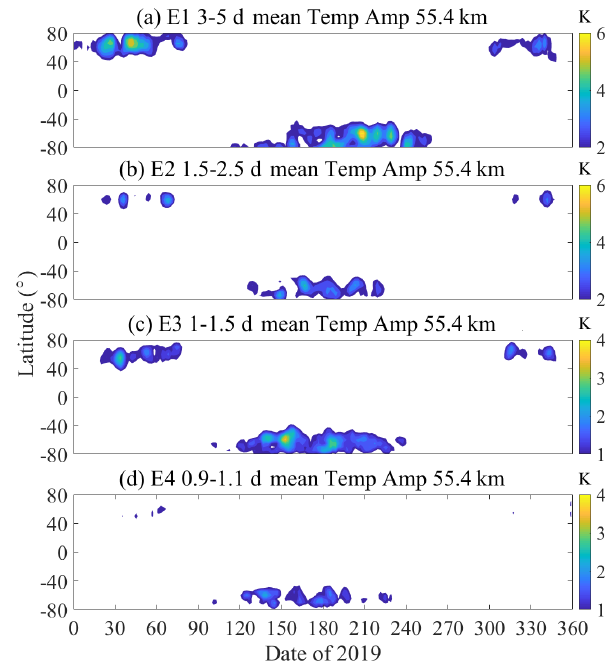
Figure 1. The global latitude–temporal variation structures of the (a) E1, (b) E2, (c) E3 and (d) E4 planetary waves during 2019. White areas represent small-amplitude data (corresponds to the right color bar). The date indicates the day of the